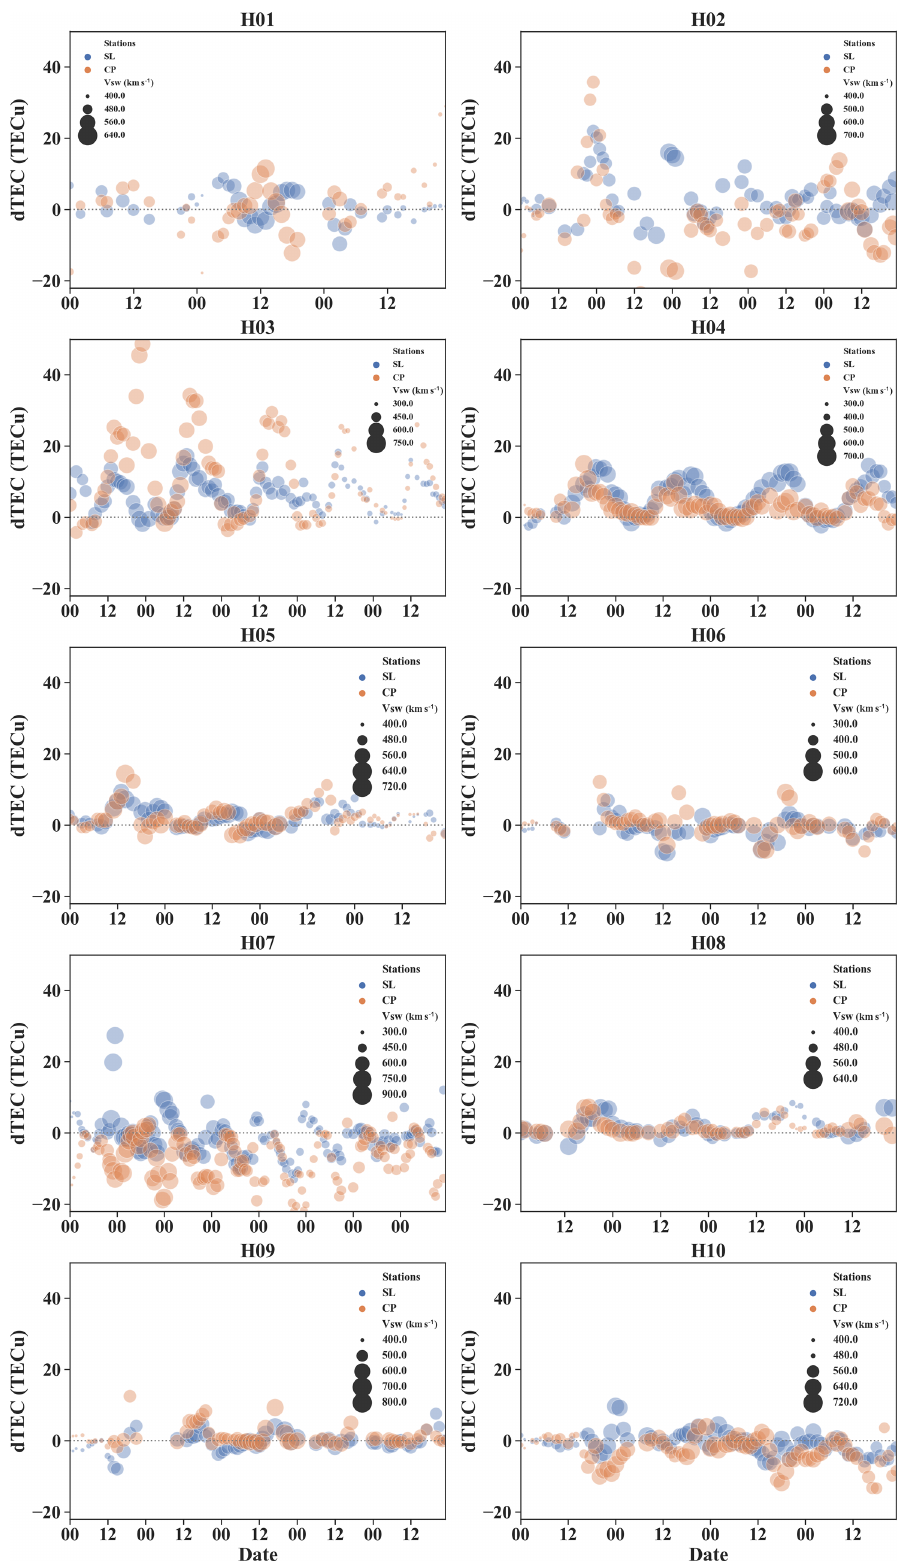
Figure 5. Solar wind velocity analysis during HILDCAA intervals. The blue and coral colors refer to São Luís and Cachoeira Paulista stations, respectively, while the bubble diameter is related to velocity (kms − 1